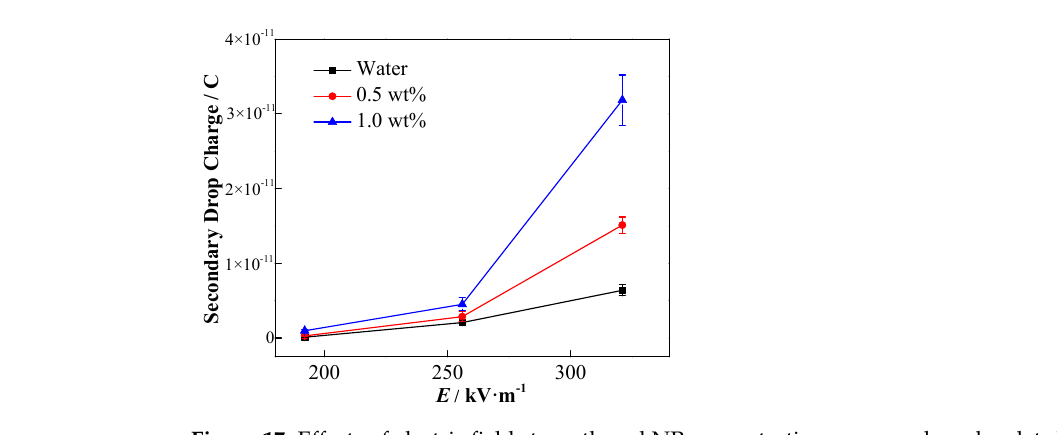
Figure 17. Effects of electric field strength and NP concentration on secondary droplet charge.